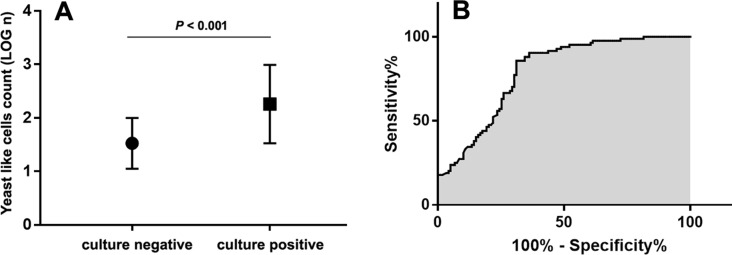
Yeastlike cells (YLC) performance for screening candiduria.(A) For YLC positive samples, YLC count (LOG n) of culture positive samples is significantly higher than culture negative samples (P < 0.001). The error bars represent the standard deviations; (B) The receiver operating characteristic curve (ROC) was utilized to determine the cutoff YLC value for candiduria identifying. The area under the curve (AUC) was 0.789 and the cutoff value was determined as 84.6 YLCs/µL.